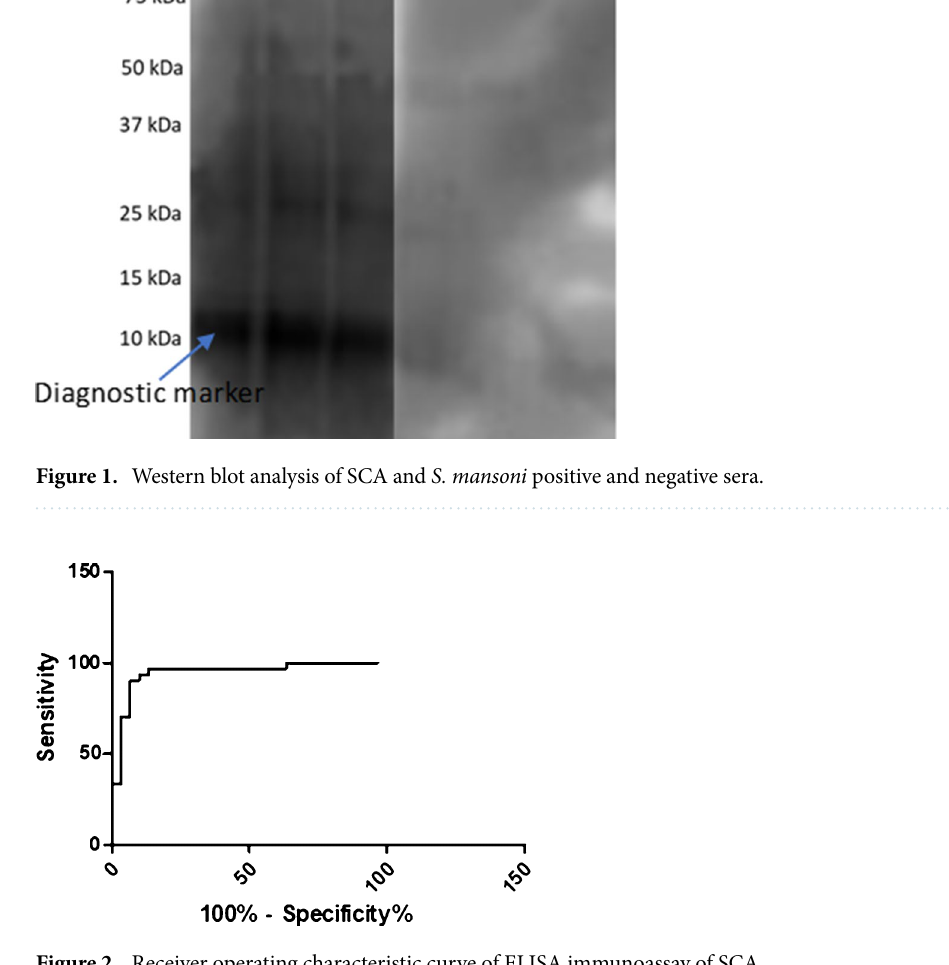
Figure 2. Receiver operating characteristic curve of ELISA immunoassay of